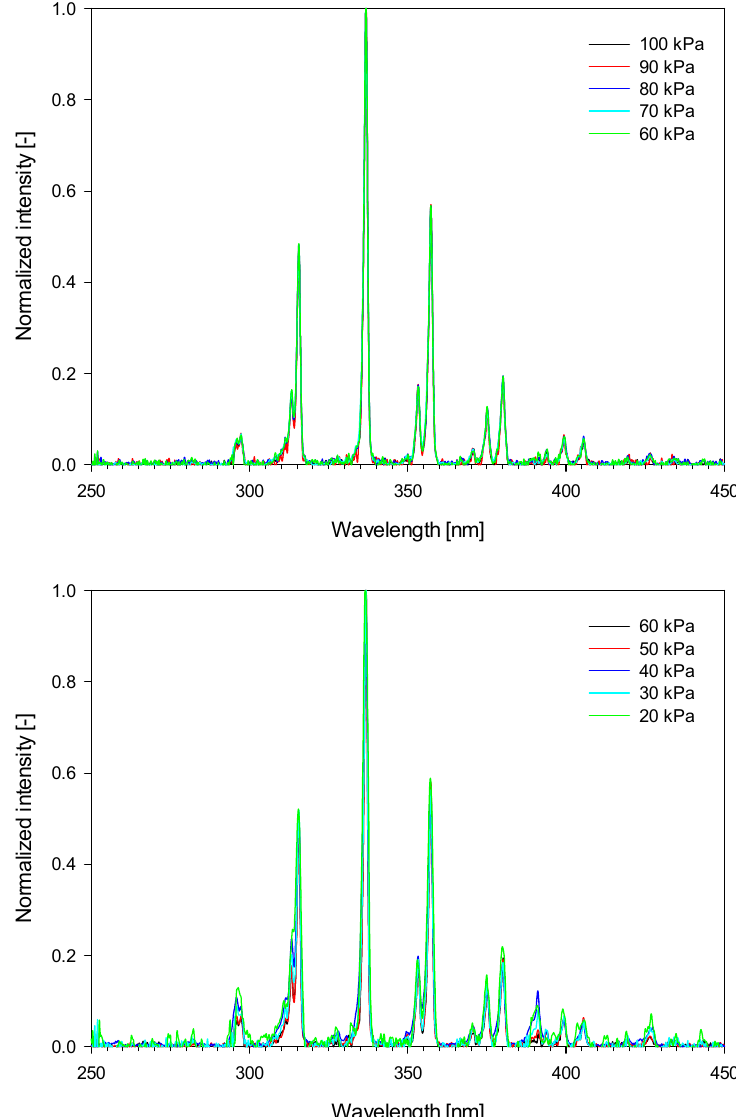
Figure 6. Normalized spectra of the corona discharges with positive and negative dc supply and 50 Hz ac supply in the 100–20 kPa pressure range using a needle-plane gap (diameter = 1.0 mm, gap = 30 mm).